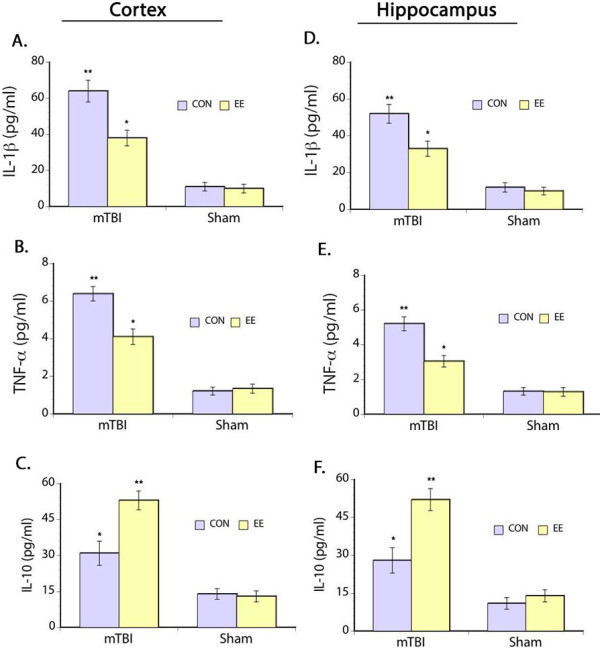
Inflammatory markers. ELISA results of IL-1β (A), TNF-α (B) and IL-10 (C) levels in the prefrontal cortex and hippocampus (D-F). Increased levels of IL-1β and TNF-α are evident in both prefrontal cortex and hippocampus of mTBI rats but housing animals in EE after injury modulated the upregulation in these pro-inflammatory cytokines. In contrast, levels of the anti-inflammatory cytokine IL-10 is decreased in mTBI rats assigned in the control environment compared to the mTBI rats housed in EE. Sham groups show minimal expression of both anti-inflammatory and pro-inflammatory cytokines. *p < 0.05, **p < 0.01.